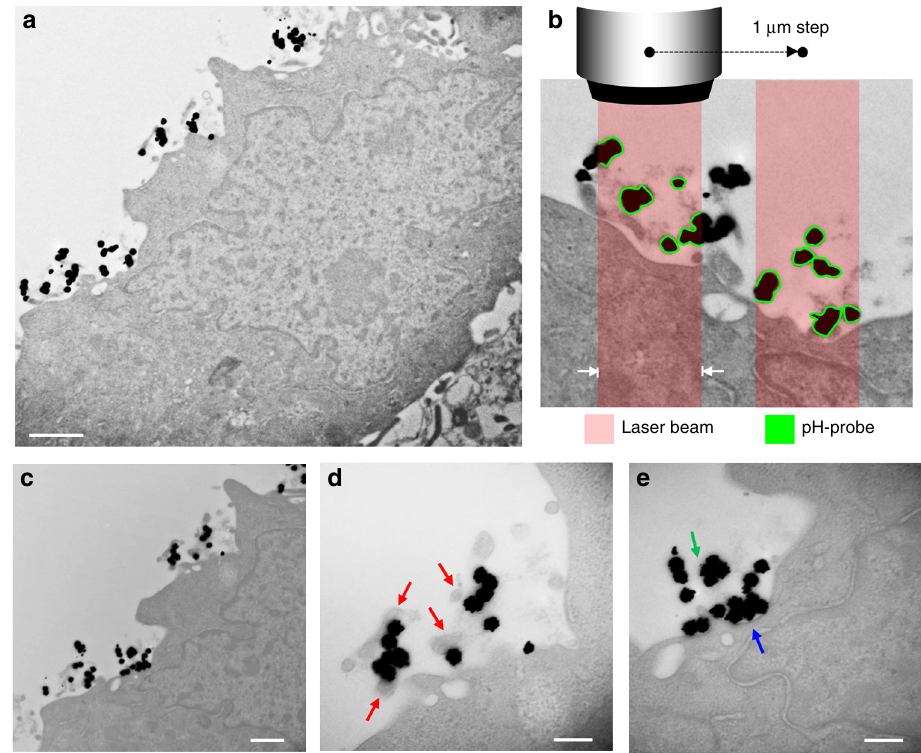
Fig. 3 Con fi rmation of AuNP anchoring to the outer cell surface by TEM. Images were collected from MKN28 cells. The cells were fi xed after 1 h from the completion of AuNP attachment, in order to con fi rm also the lack of endocytosis during SERS experiments. The cells embedded into resin were trimmed through their thickness using an ultramicrotome to obtain 90 nm thin sections. The images in a and b were taken from the same section, but at different magni fi cation (7 and 17 k, respectively). Similarly, images in c – e belong to another section of the same cell at magni fi cation 17, 50, and 50 k, respectively. In b the pH-sensitive 4-MBA SAM of each AuNP illuminated by the laser beam is depicted with green lines. The thickness of the lines does not represent the real thickness of the SAM, which can be assumed as 0.78 nm 31 . Red arrows in d indicate sections of microvilli. The 90 nm thickness of the slices for TEM analysis is equal to the average size of the AuNP, namely some of the AuNP were trimmed by the diamond knife. For this reason, in the nanosensors indicated by the green arrow in e the point of contact with the microvillus may have been removed during trimming. The blue arrow in e points out an aggregation of AuNP lying on outer cell membrane, whose maximum thickness can be estimated as about 100 nm. Scale bars: 1 µ m in a , 500 nm in c , 200 nm in d and e . In b the laser beam waist is 700 nm (length between the two white